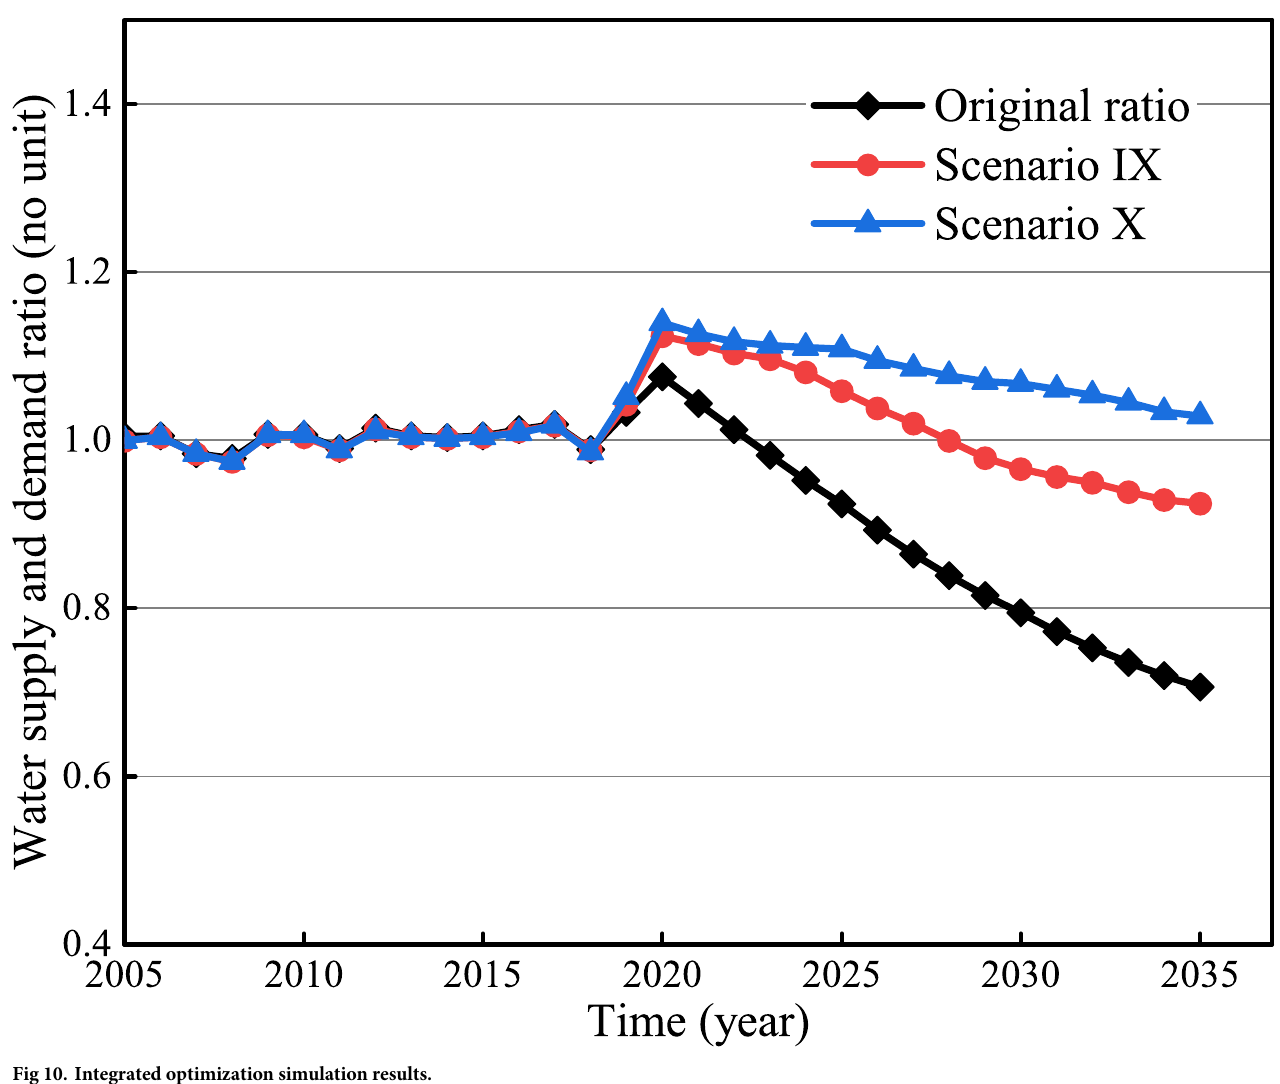
Fig 10. Integrated optimization simulation